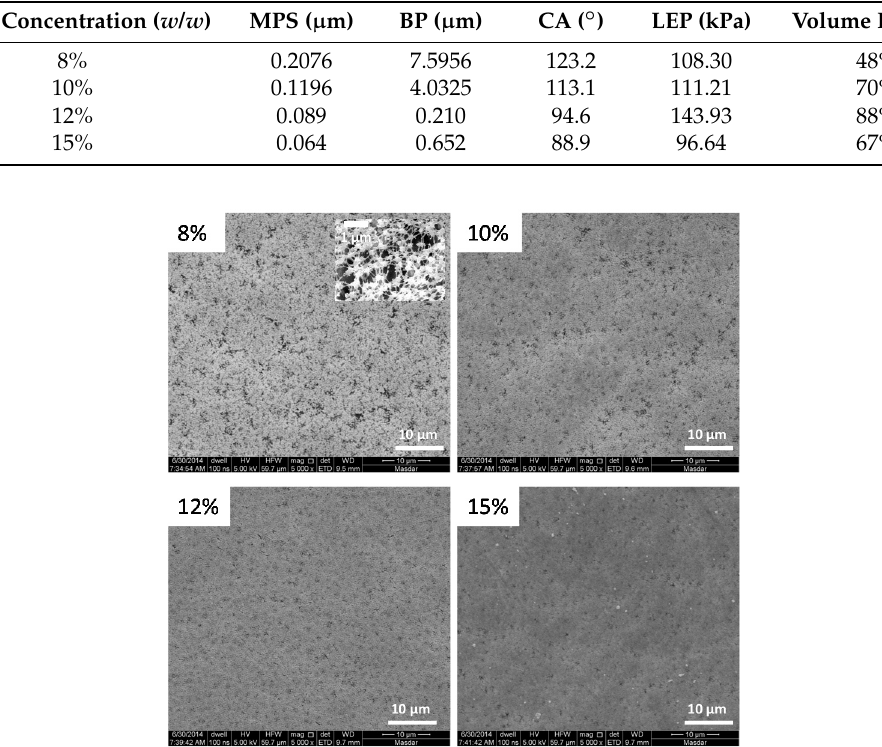
Table 4. Membranes properties with casting thickness of 500 μ m and PVDF concentration of